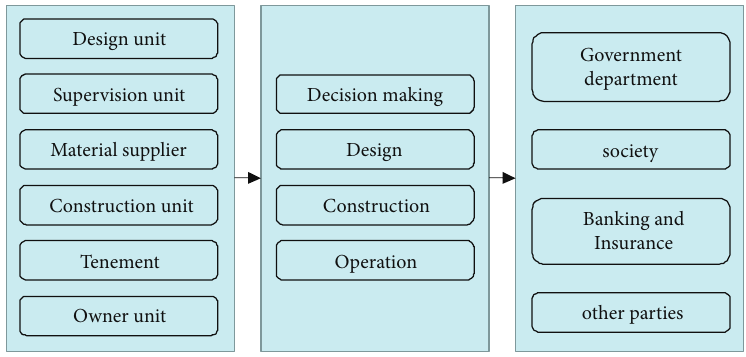
Figure 6: Project participants in the green building implementation